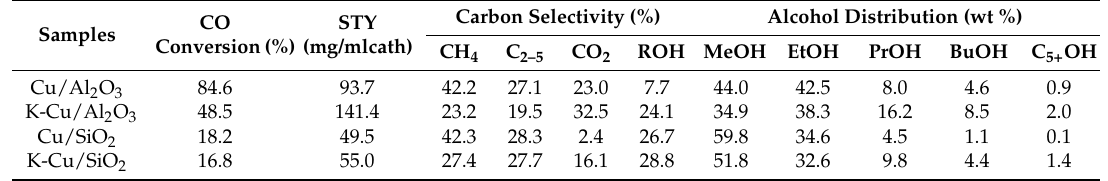
Table 2. The performances of Cu/Al 2 O 3 , K-Cu/Al 2 O 3 and Cu/SiO 2 , K-Cu/SiO 2